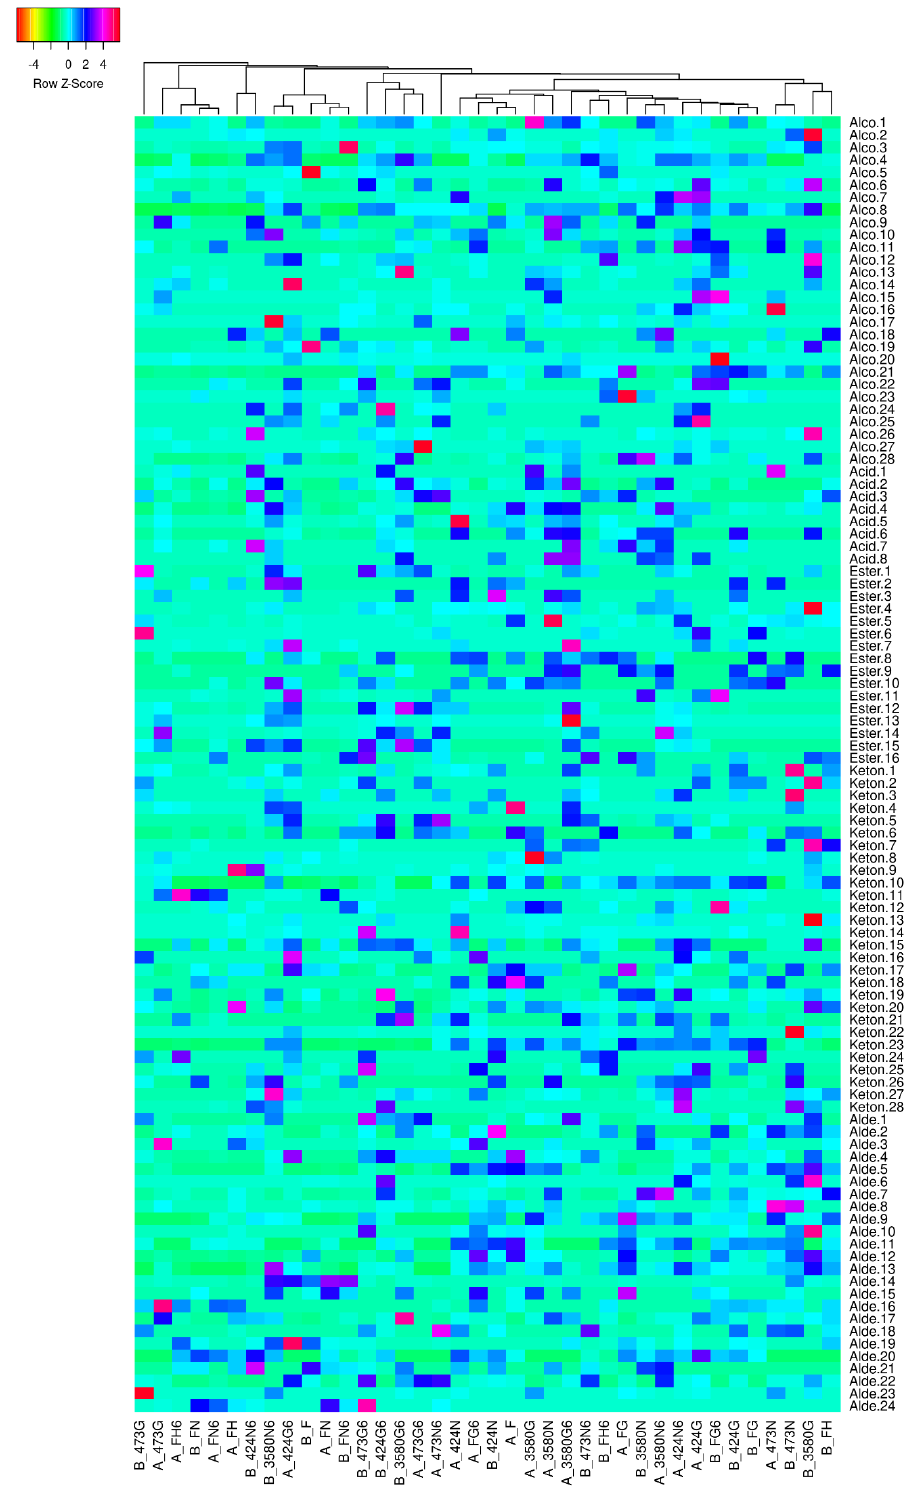
Figure A1. Heatmap of relative quantification of significant molecules ( P < 0.05). Sample abbreviations: A_3580G and B_3580G = Z. mobilis 3580 not leavened doughs added with glucose; A_3580N and B_3580N = A_3580G and B_3580G added with NaCl; A_424G and B_424G = Z. mobilis 424 not leavened doughs added with glucose; A_424N and B_424N = A_424G and B_424G added with NaCl; A_473G and B_473G = Z. mobilis G473 not leavened doughs added with glucose; A_473N and B_473N =